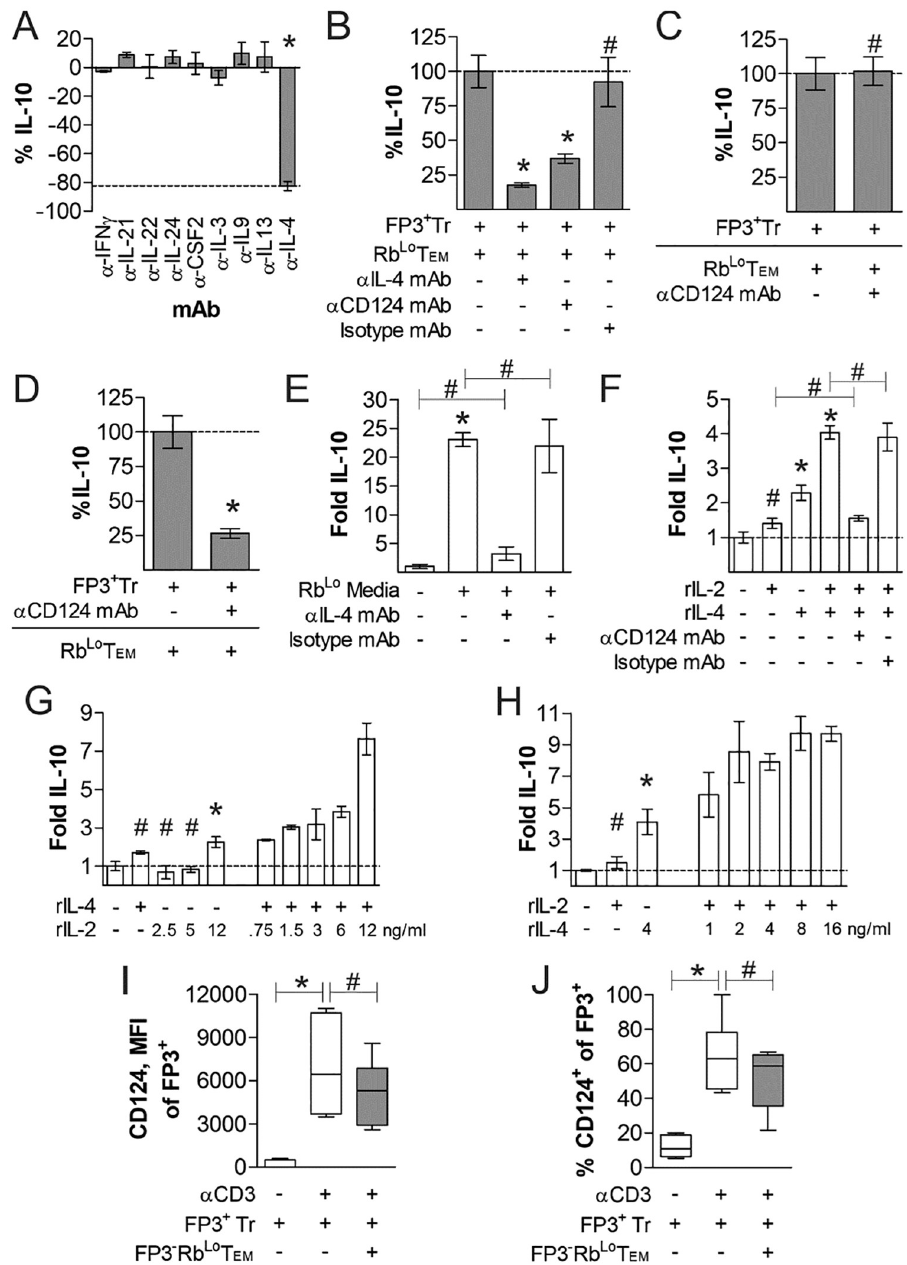
Fig 5. IL-4 and FoxP3 + Treg IL-4R α (CD124) mediates Treg IL-10 production. FoxP3 + Tregs and Rb Lo Tem were stimulated in co-culture as before for 3 days with the addition of cytokine (A) or receptor (B) neutralizing antibodies to identify the mediator of IL-10 synergy. (C) To determine whether IL-4 was acting on Rb Lo Tem cells or FoxP3 + Tregs, (C) Rb Lo Tem cells were incubated with CD124 neutralizing antibody, washed, then co-cultured with fresh FoxP3 + Tregs as before (C); and then compared to pre-incubating FoxP3 + Tregs with CD124 antibody followed by co-culture with Rb Lo Tem cells (D). FoxP3 + Tregs were stimulated as before in monoculture supplemented with either conditioned media from stimulated Rb Lo Tem cells (E) or various concentrations, denoted in ng/mL, of recombinant IL-2 or IL-4 (F-H) with and without neutralizing IL-4 or CD124 antibodies (E-H). (I-J) FoxP3 + Tregs were cultured with and without α CD3 ε stimulation, as well as with and without Rb Lo Tem cells. At day 3, cells were harvested and stained for CD124 expression, and analyzed by geometric mean fluorescence intensity (I) and the percent CD124 positive among FoxP3 + Tregs (J). � = p < 0.05; # = p > 0.05. P value calculated from Student’s T-Test, with comparisons to control unless specified. Error bars show mean with SEM. For A-H, n = 3 to 6 experiments. For I-J, n = 6